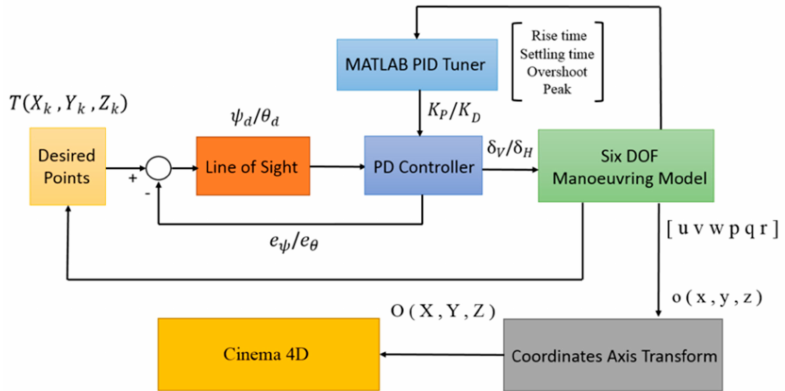
Figure 7. The flow chart of the autopilot system combining with the Cinema 4D modelling.